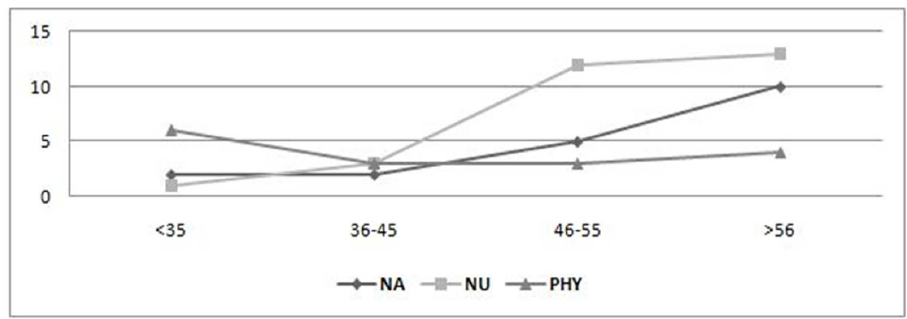
Figure 2. Age distribution of musculoskeletal disorders. NA, nursing aides; NU, nurses; PHY, physicians.